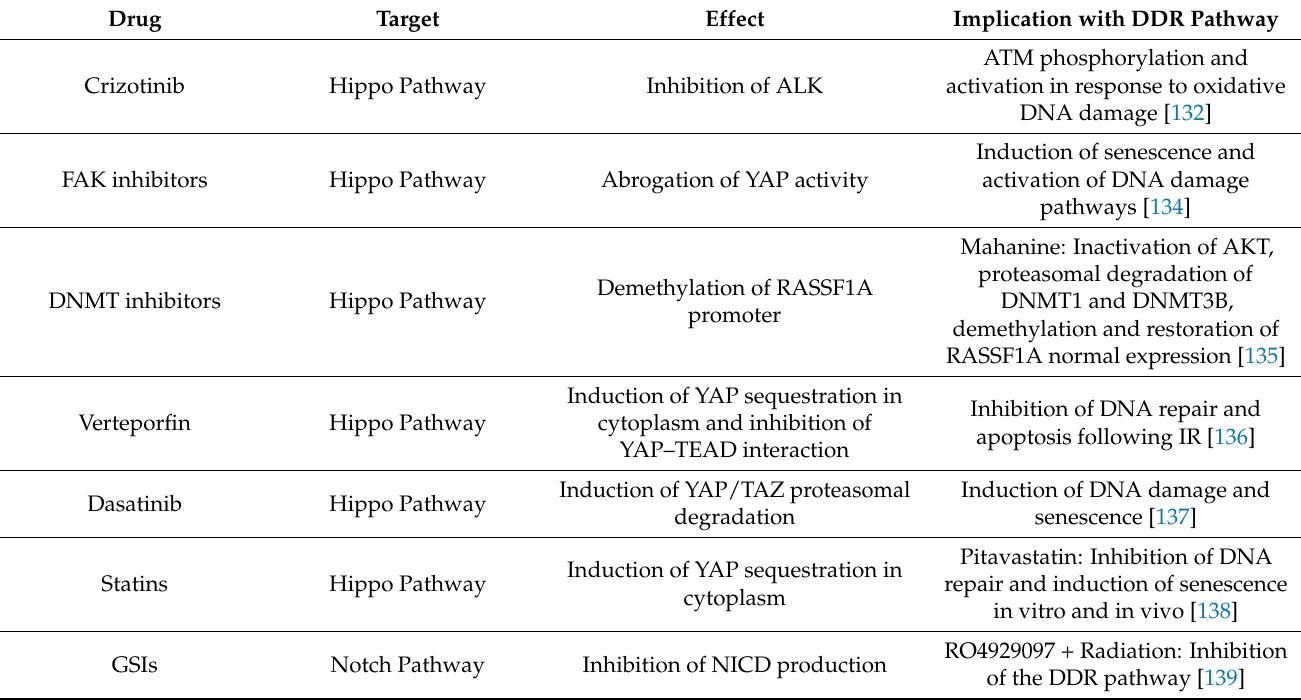
Table 1. Therapeutic interventions potentially modulating the Hippo/Notch/DDR